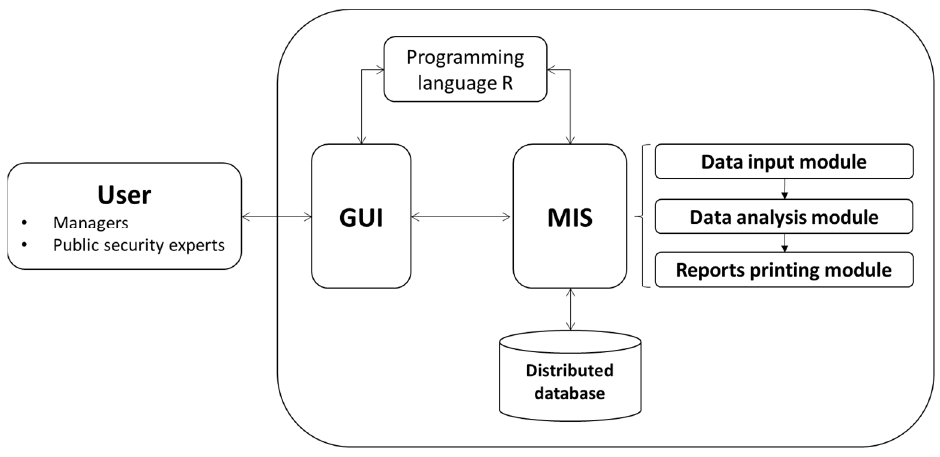
Figure 2. Components of proposed MIS.